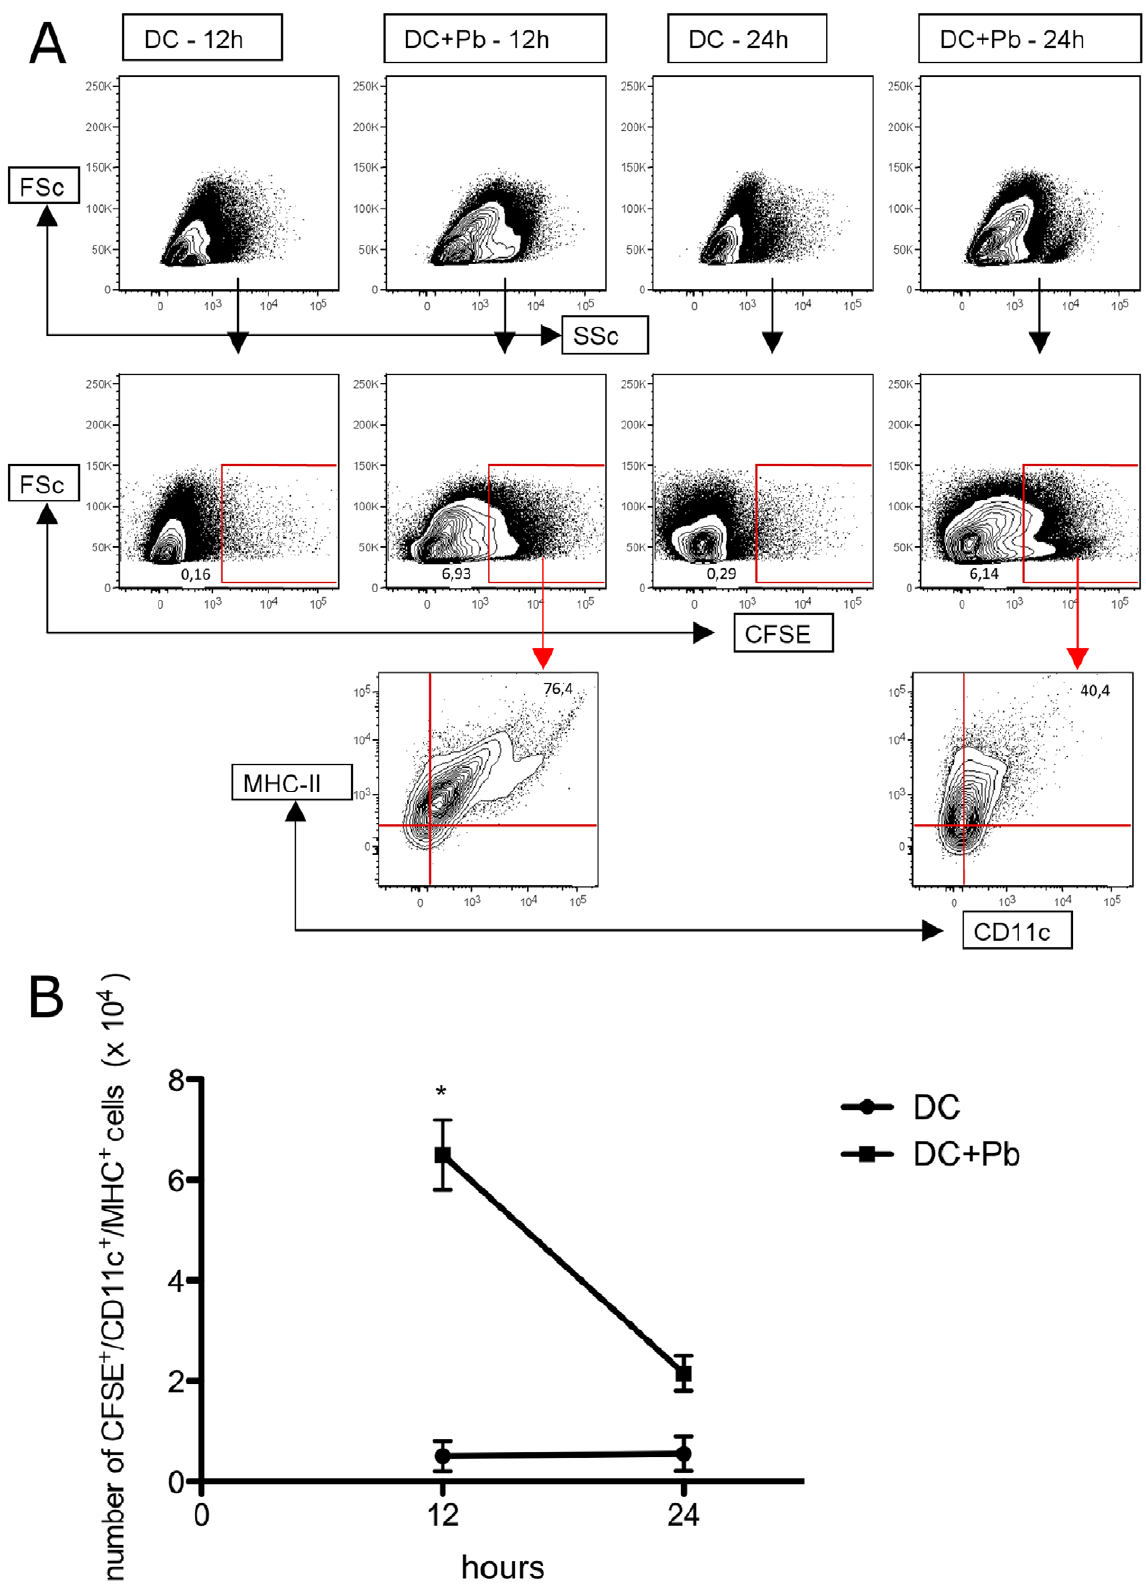
Figure 2. Migration of BM-DC to the lymph nodes. BM-DC were incubated with Pb labeling with CFSE and injected into the lung. After 12 and 24 hrs the lymph nodes cells were analyzed by citometry. A-Figure representative of 3 different experiments, where the gate represent positive cells, determined by FMO, as described in the M&M. The numbers represent the percentage of positive cells. B- At 12 and 24 hrs after Pb infection, the absolute numbers of CFSE + /CD11c + were determined in the lymph nodes. Error bars represent the SEM. *p , 0.05 when compared with only DC.